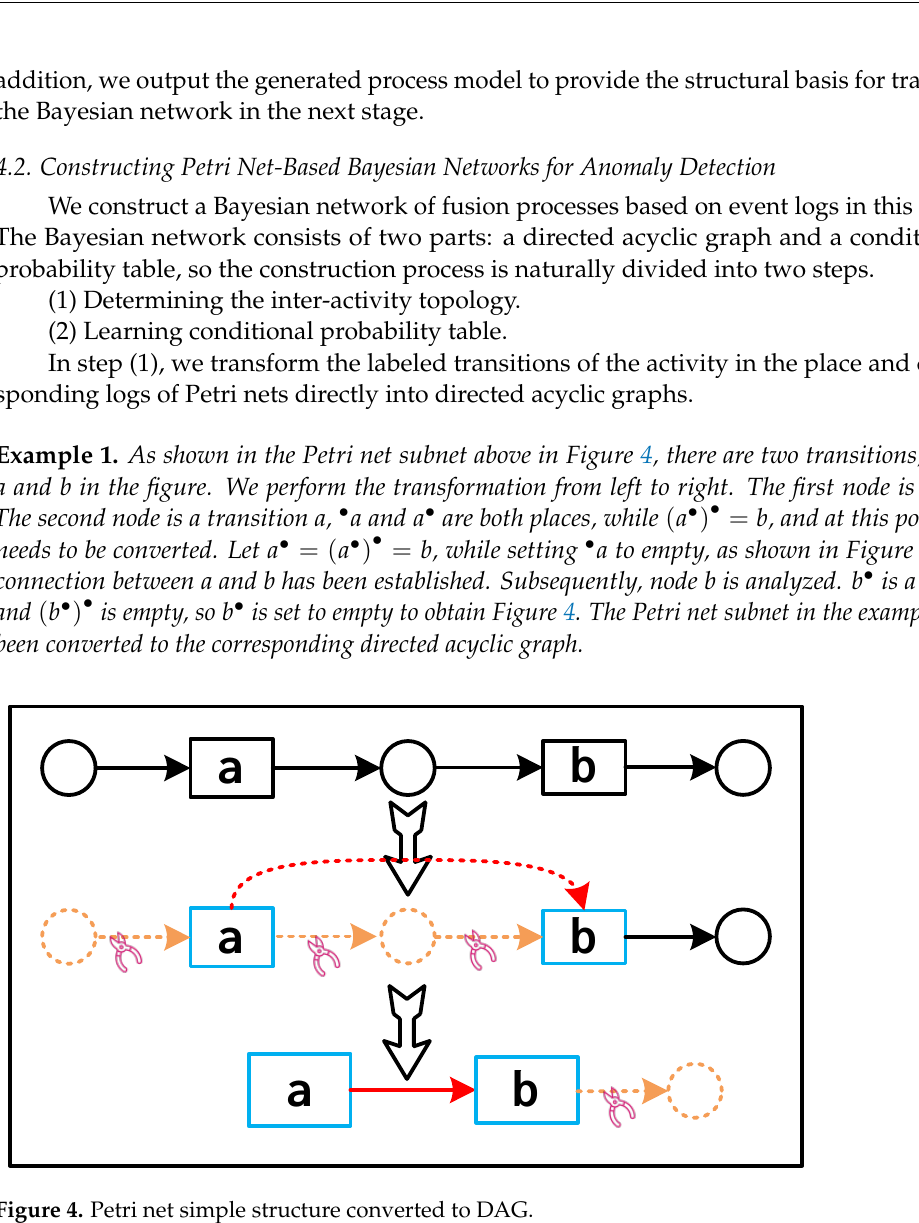
Figure 4. Petri net simple structure converted to DAG.